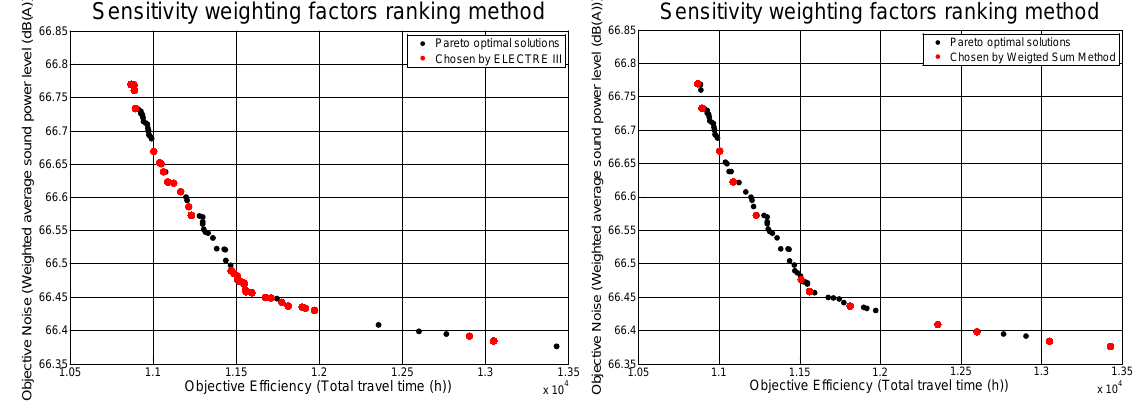
Figure 6. Sensitivity ranking method for weighting